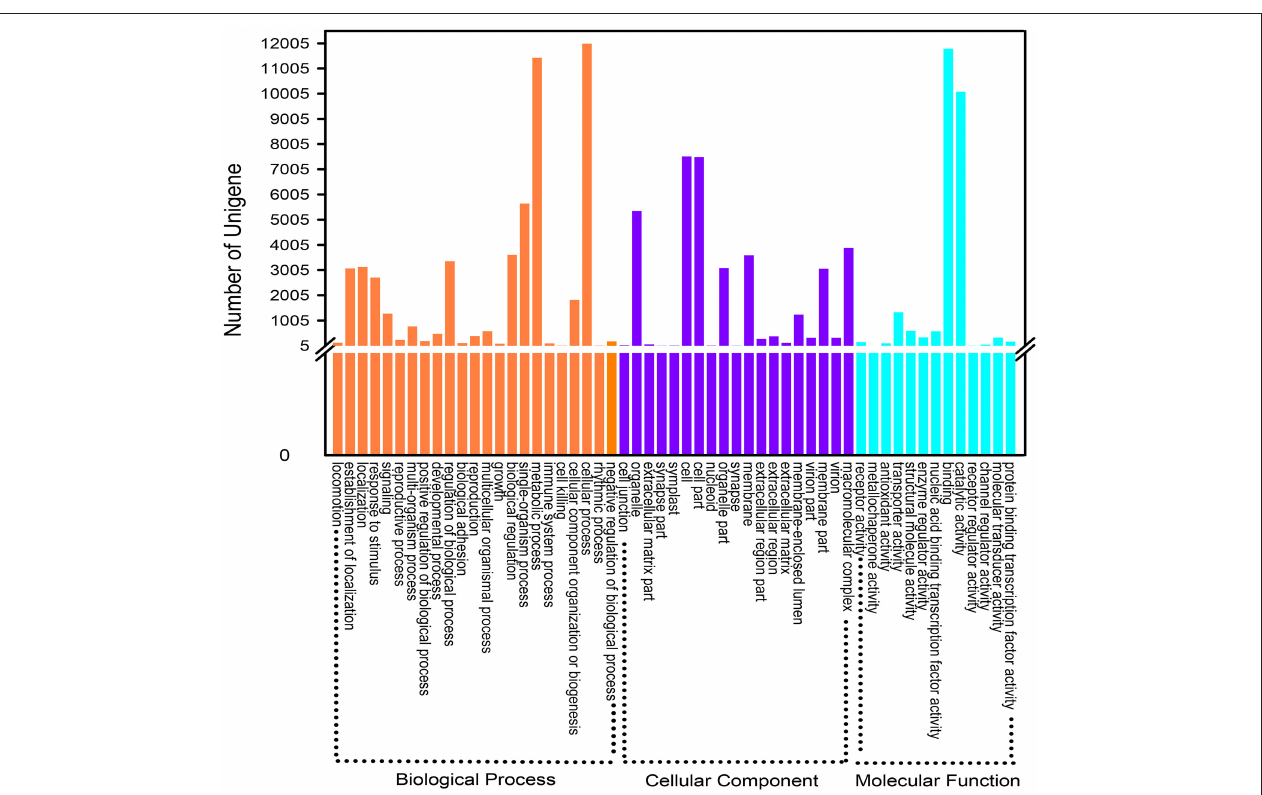
FIGURE 4 | Gene Ontology classification of assembled unigenes. A total of 20,165 unigenes were categorized into three main categories: “biological process,” “cellular component,” and “molecular function.”